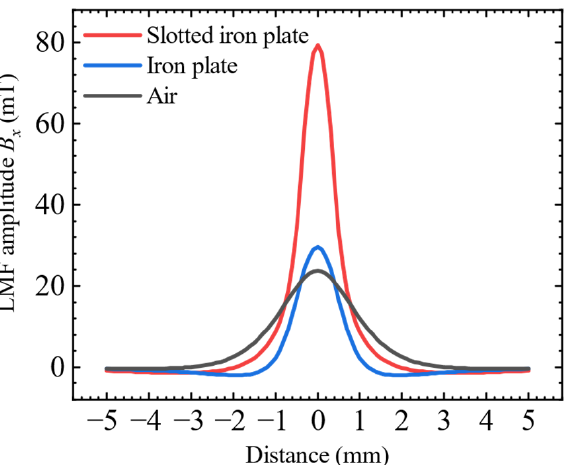
Figure 12. Comparison of LMF distribution between slotted iron plate, iron plate, and air lift-off